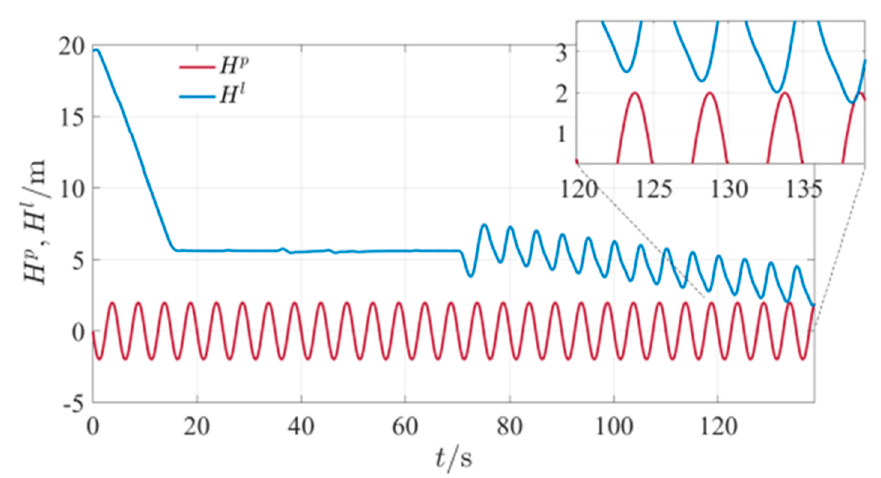
Figure 44. The evolution of H p and H l vs. time when A w = 4 m, T w = 5 s.